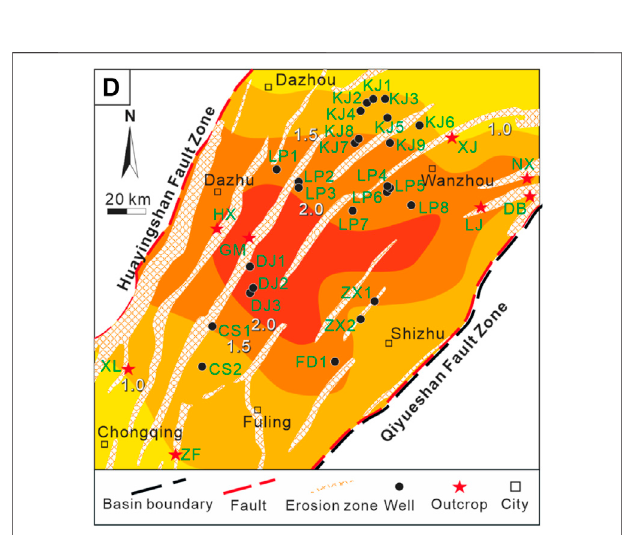
FIGURE 7 | Total organic carbon (TOC, wt%) in the black shale of the Dongyuemiao member.